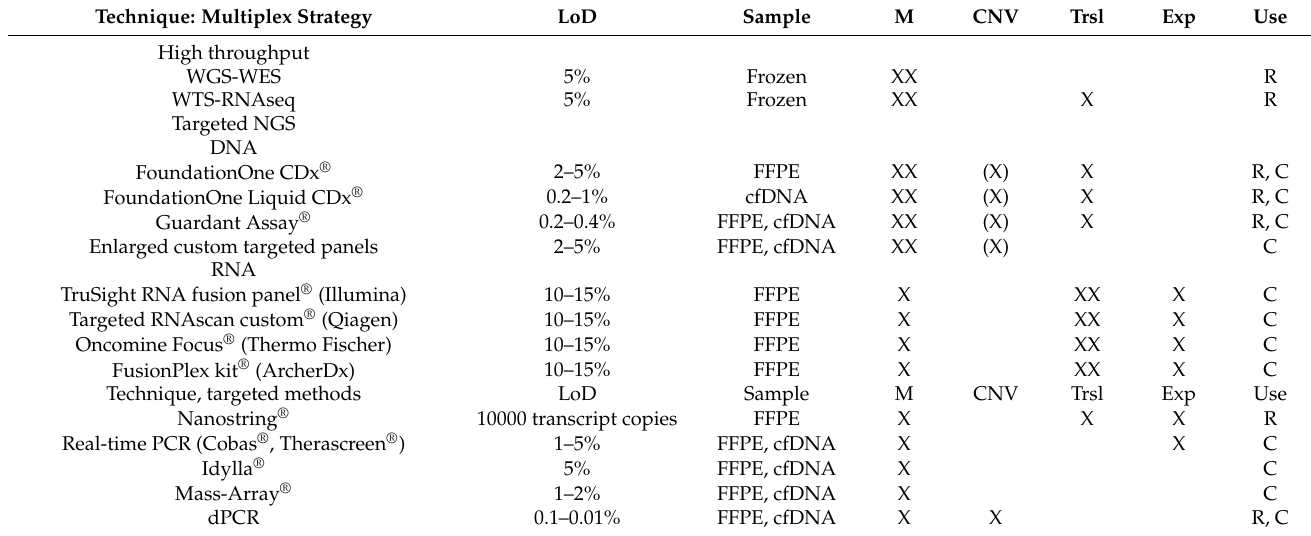
Table 2. Molecular